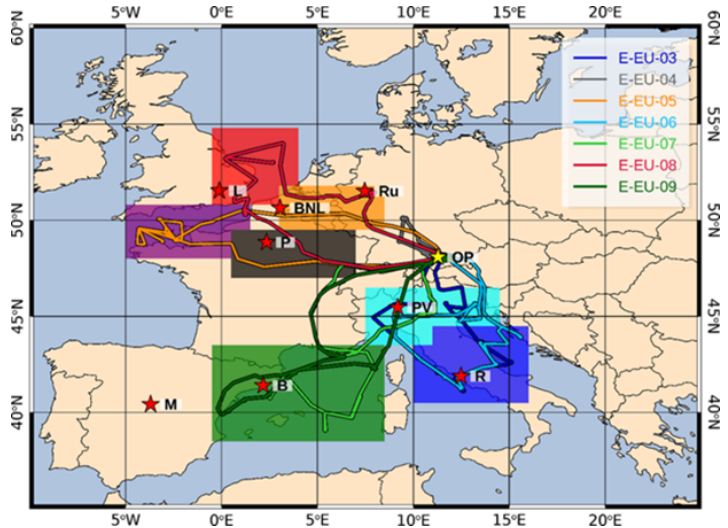
Figure 4. HALO flight tracks during the EMeRGe campaign in Europe on 11, 13, 17, 20, 24, 26, and 28 July 2017 (E-EU-03 to E- EU-09, respectively, colour coded). The specific flight times are presented in Table 3. MPC target areas are colour coded by shading: the English Channel (purple), the North Sea (red) Benelux/Ruhr (orange), Paris (black), the Po Valley (cyan), central Italy (blue), and the Eastern Mediterranean (green). Distinctive locations/regions are marked with red stars, M: Madrid, B: Barcelona, P: Paris, L: London; BNL: Benelux; Ru: Ruhr area; PV: Po Valley, R: Rome. The coordinates of the MPC areas can be found in the Supplement (Sect. S8). The position of the HALO base at DLR in Oberpfaffenhofen (OP) is also indicated by a yellow star for reference.